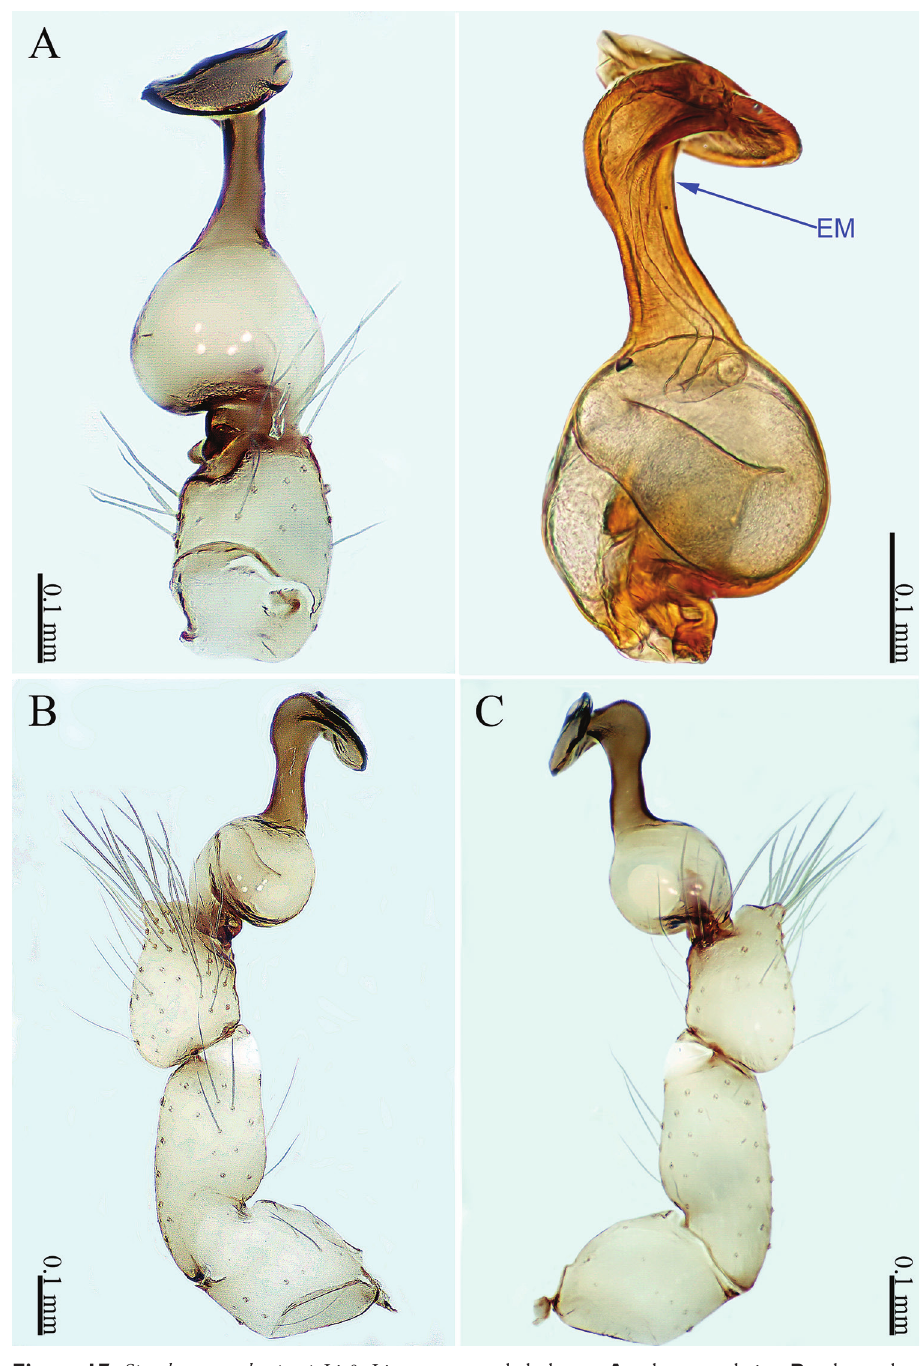
Figure 17. Sinoderces saraburiensis Li & Li, sp. nov., male holotype A palp, ventral view B palp, prolat- eral view C palp, retrolateral view D palpal bulb, ventral view Abbreviation: EM